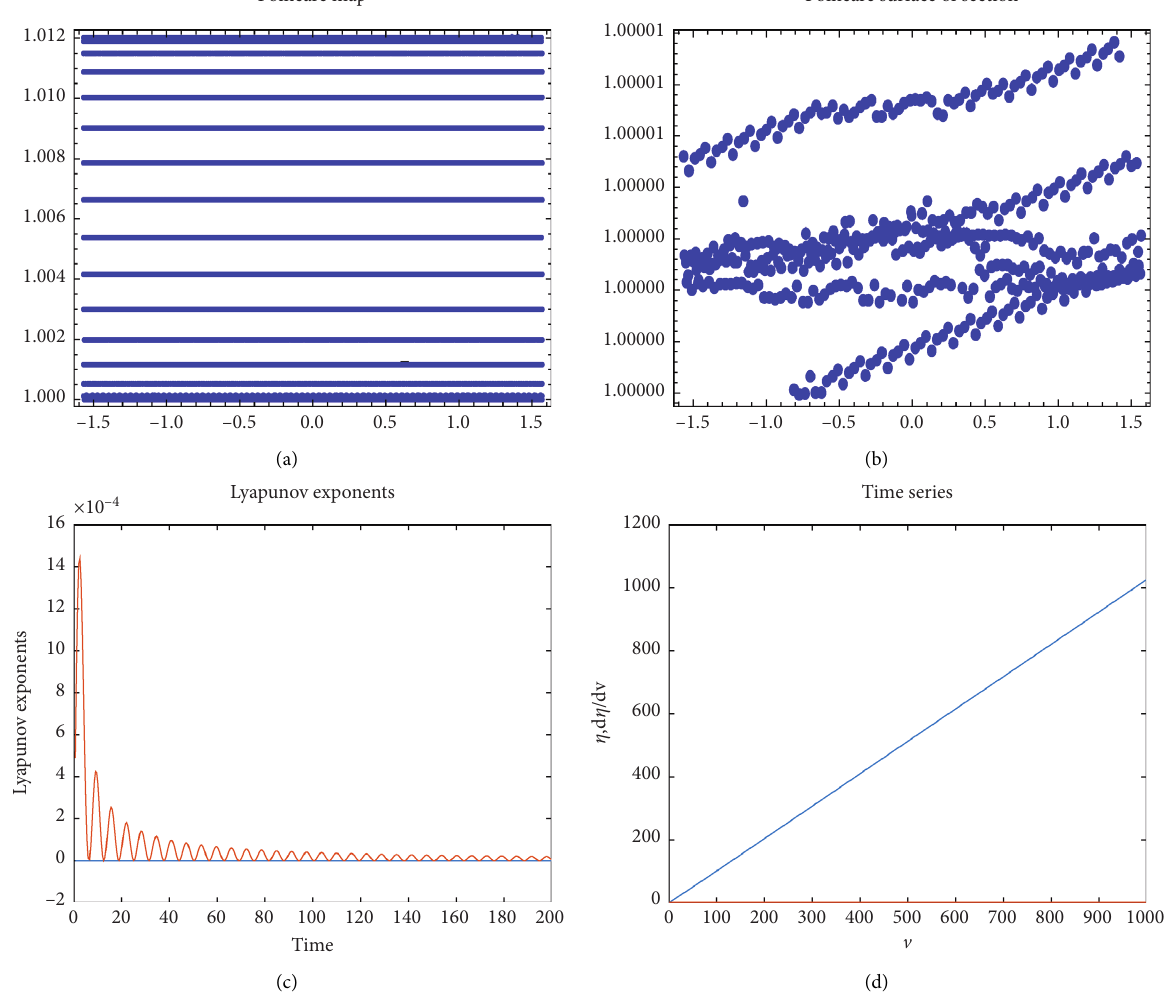
� 3 . 36 E + 09 , D � − 4 E + 08 , B � 1596 . 387 , C � − 103631 , ∗ ∗ ∗ ∗